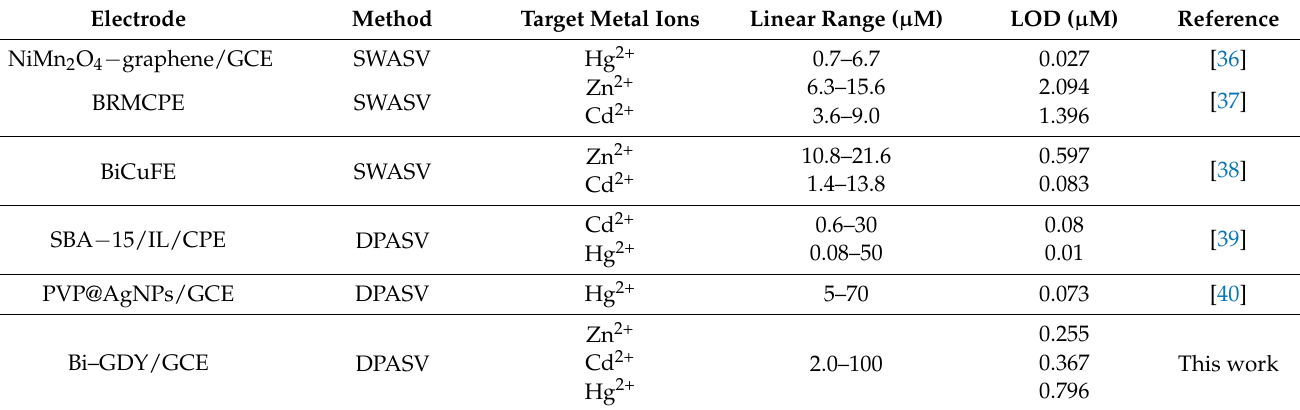
Figure 7. DPASV curves of different concentrations of ( A ) Zn 2+ , Cd 2+ , and ( C ) Hg 2+ (2.0, 4.0, 6.0, 8.0, 10.0, 20.0, 40.0, 60.0, 80.0, 100.0 µ M); the linear plots of I p versus the logarithm of concentration ( B ) Zn 2+ and Cd 2+ , and ( D ) Hg 2+ . Table 2. Comparison of different modified electrodes for determination of Zn 2+ , Cd 2+ and Hg 2+ .